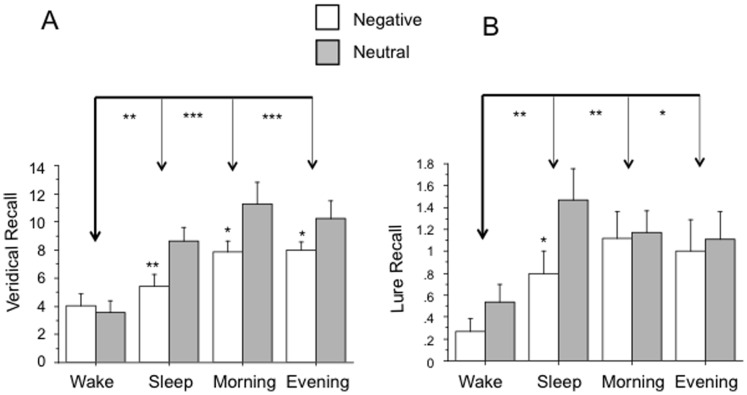
Comparison of Veridical Recall and Lure Recall across all participants including experimental (Wake, Sleep) and control (Morning and Evening) groups.Panel (A) shows Veridical Recall and (B) shows Lure Recall. Upper brackets depict post-hoc comparisons of the 4 groups collapsing across Valence. Asterisks directly above bars for negative items depict post-hoc comparison of negative vs. neutral items within individual groups for Veridical Recall (for which the Group x Valence interaction was a trend). * p<.05, ** p<.01, *** p<.001.